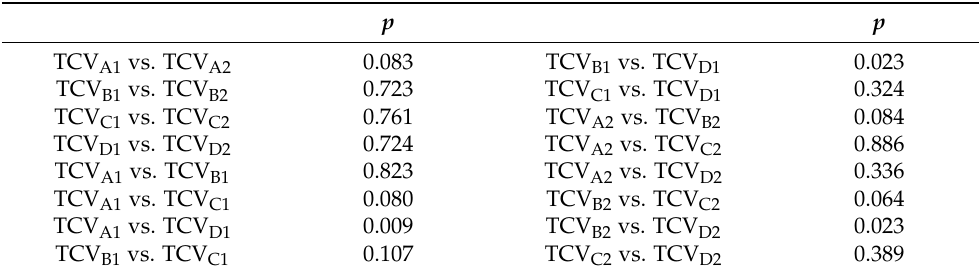
Table 8. Differences of TCV in different